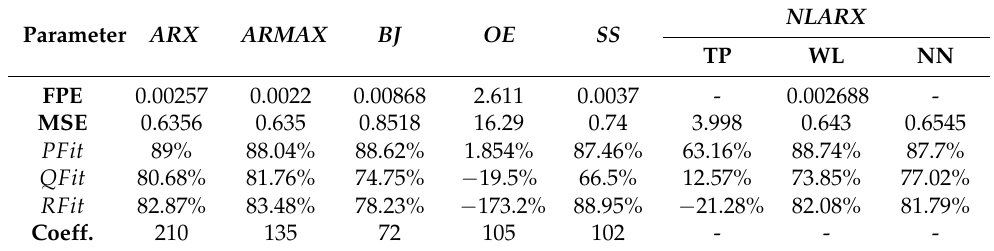
Table 1. Comparison Analysis of Linear and Nonlinear Parametric Model Responses.